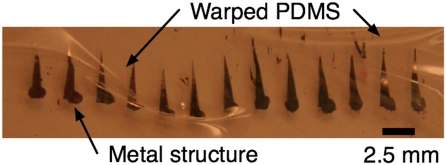
PDMS membrane that was warped when hexane-diluted PDMS was spun onto it.The triangular elements are metal that was plated on the underlying PDMS membrane.